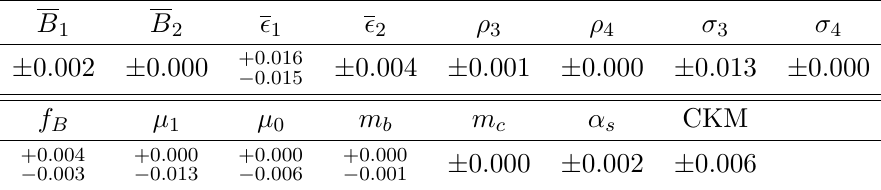
Table 8 . Individual errors for the ratio (cid:28) ( B + ) =(cid:28) ( B 0 ) in the PS mass scheme.